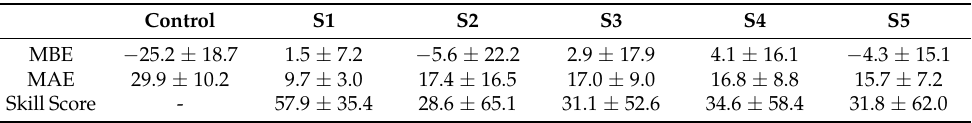
Table 2. Simulation mean bias error (MBE) and mean absolute error (MAE) presented as the aver- age ± standard